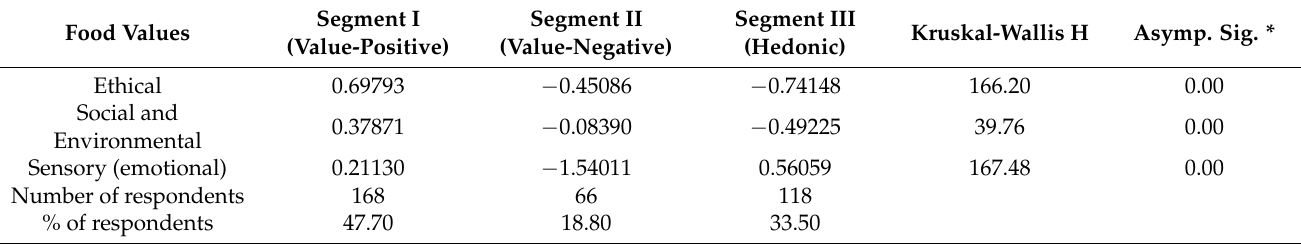
Table 5. Resident segments.